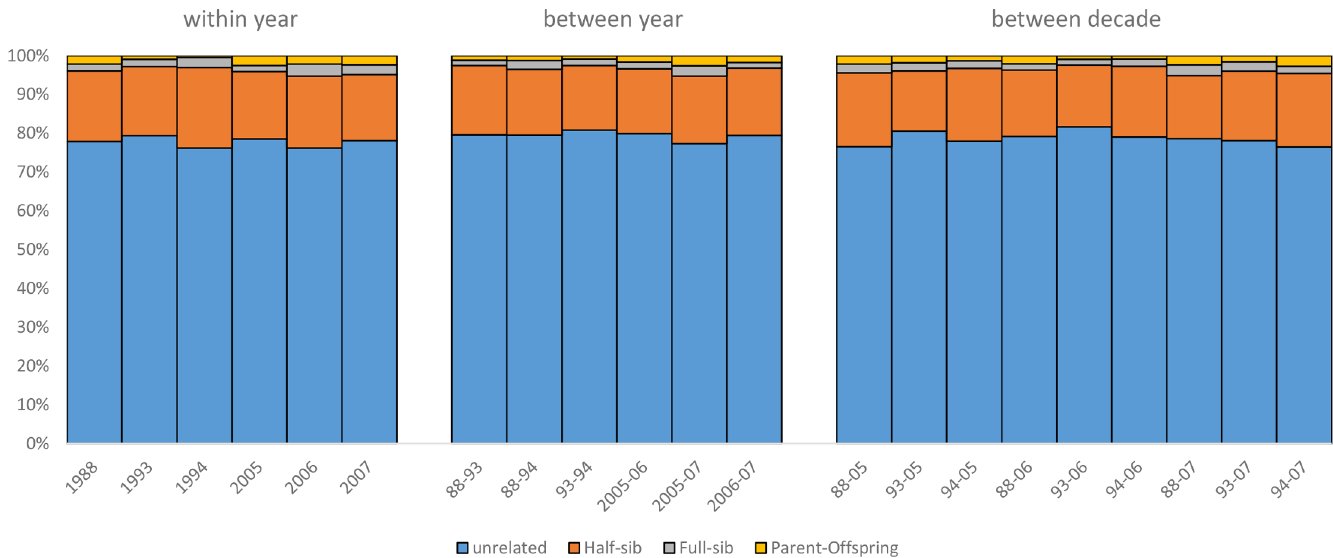
Fig 7. The proportion of pairwise genealogical relationships estimated for beluga whales sampled within and between years across two decades near Kasegaluk Lagoon, Alaska. Maximum likelihood estimates of four relationship categories were estimated from genotypic data using the program ML - RELATE . The stacked bars represent the proportions of distantly/unrelated individuals to closely related individuals (i.e., parent-offspring, full-sib and half-sib or equivalent) for a subset of the 20-year data set comprising the first three years (1988, 1993, 1994) and the last three years (2005, 2006, 2007).